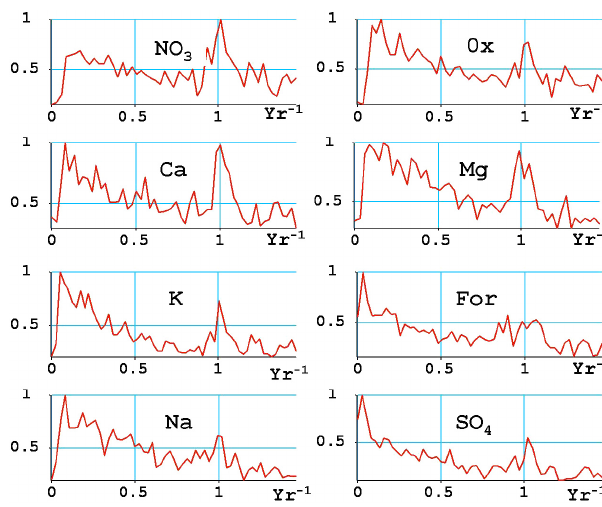
Figure 12. Spectra (in yr − 1 ) of nitrate (NO 3 ), oxalate (Ox), calcium (Ca), magnesium (Mg), potassium (K), formate (For), sodium (Na), and sulfate (SO 4 ) concentration depth profiles as a function of time delay